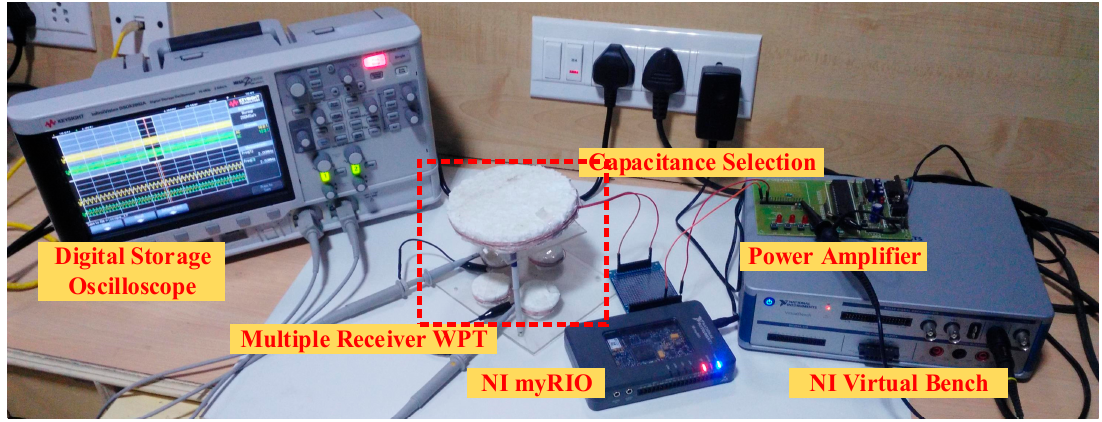
Figure 15. Experimental setup of proposed MRWPT system.